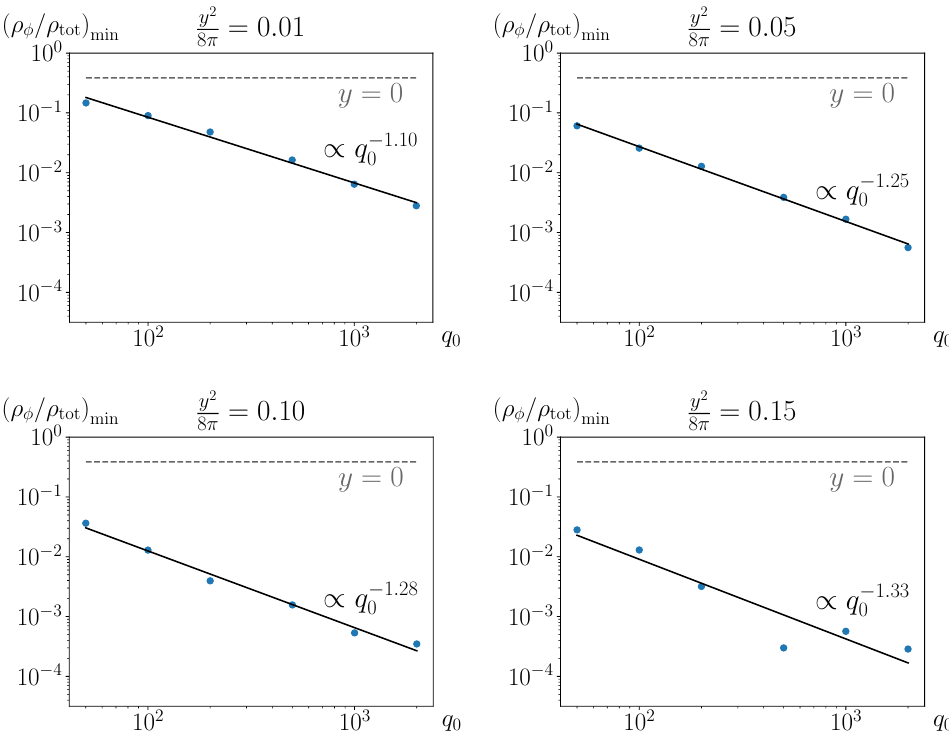
Figure 8. ( ρ φ /ρ tot ) min as a function of q 0 and y for b = 0 . 9 , λ = 4 . 05 , Φ 0 = f = M pl . The blue points are the simulation results, and the black line is the best fit with a power law q x also shows in gray the power law best fit for the y = 0 case, which is flat at ( ρ